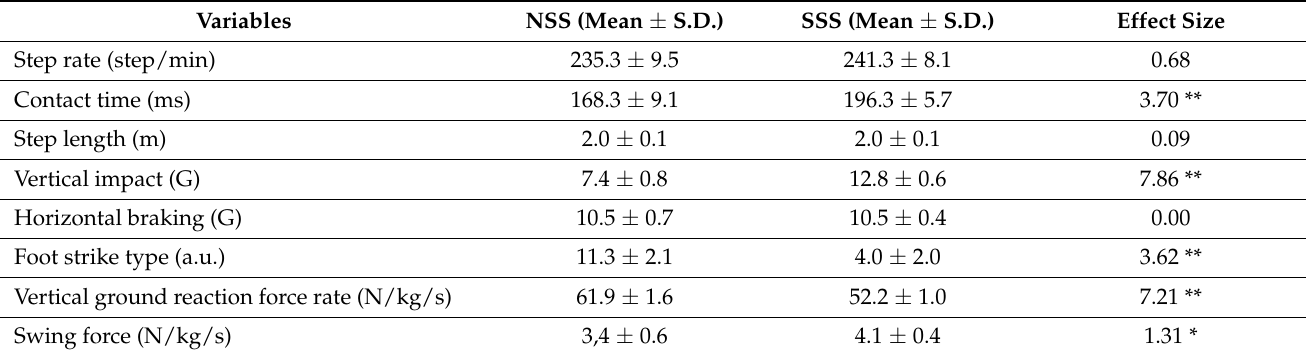
Table 2. Kinematics and kinetics values for NSS and